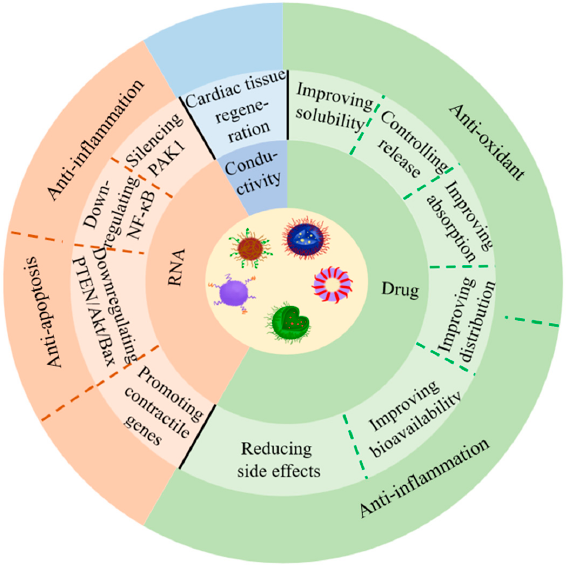
Figure 1. Application of nanoparticles for the treatment of CVDs.